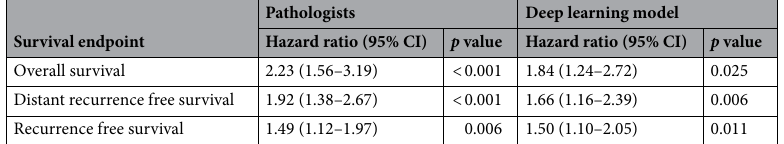
Table 5. Univariate hazard ratios showing the prognostic value of high versus low/intermediate grade tumors as assessed by pathologists or the deep learning model for different survival endpoints. Results are shown on the test set ( n =